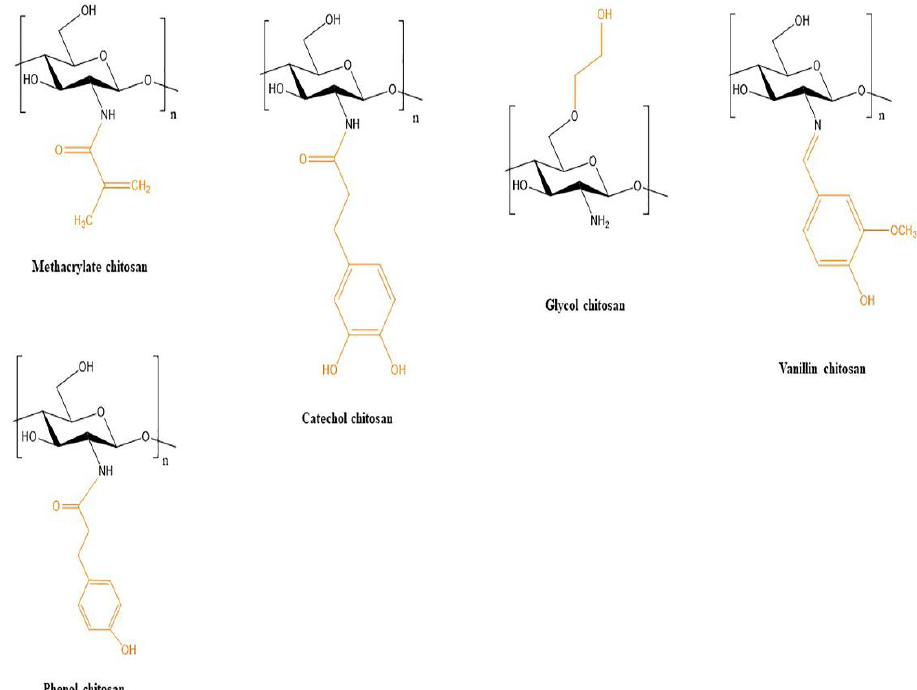
Figure 17. Chitosan derivatives have been used as biomaterial inks in 3D bioprinting.